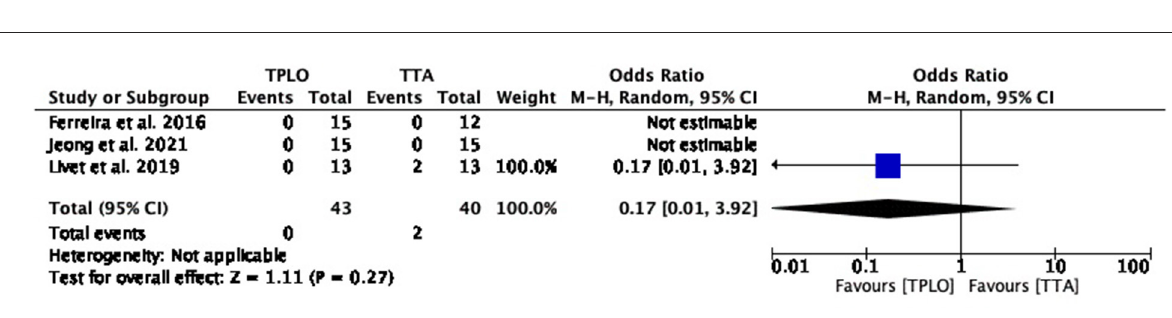
FIGURE7 Forest plot comparing TPLO vs. TTA. Odd ratios (95% CI) of tibial tuberosity fracture as a complication for TPLO and TTA.